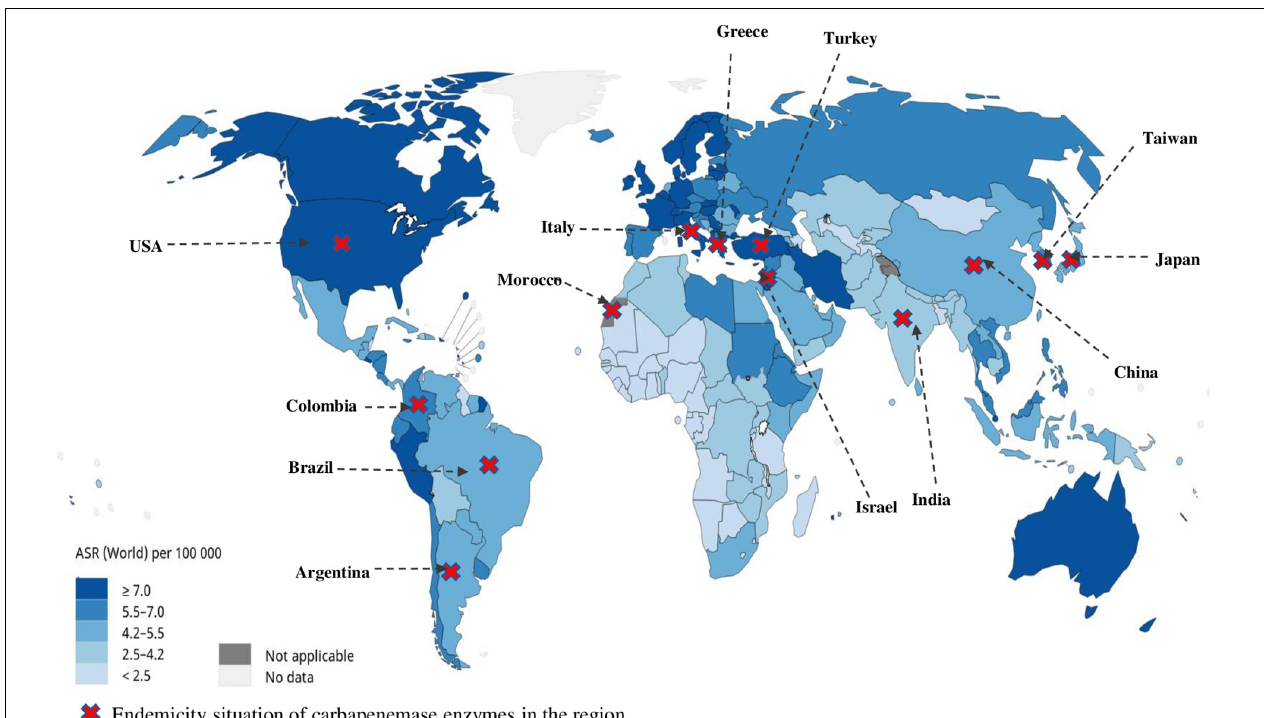
FIGURE 2 | Global repartition of leukemia incidence age-standardized rate provided by the WHO, International Agency for Research on Cancer 2019 (Data source GLOBOCAN 2018 available at http://gco.iarc.fr/today), and the overlay of current endemic distribution of carbapenemases by